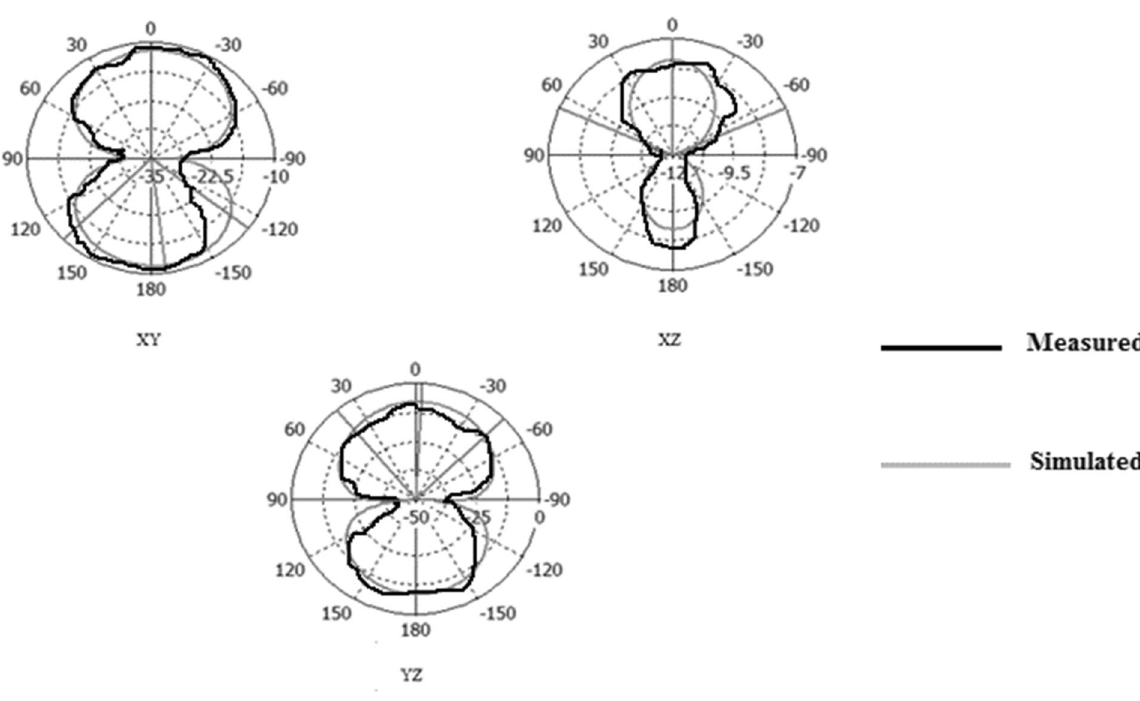
Figure 32. Simulated and measured radiation patterns of Antenna2 at the fundamental frequency of 2.55